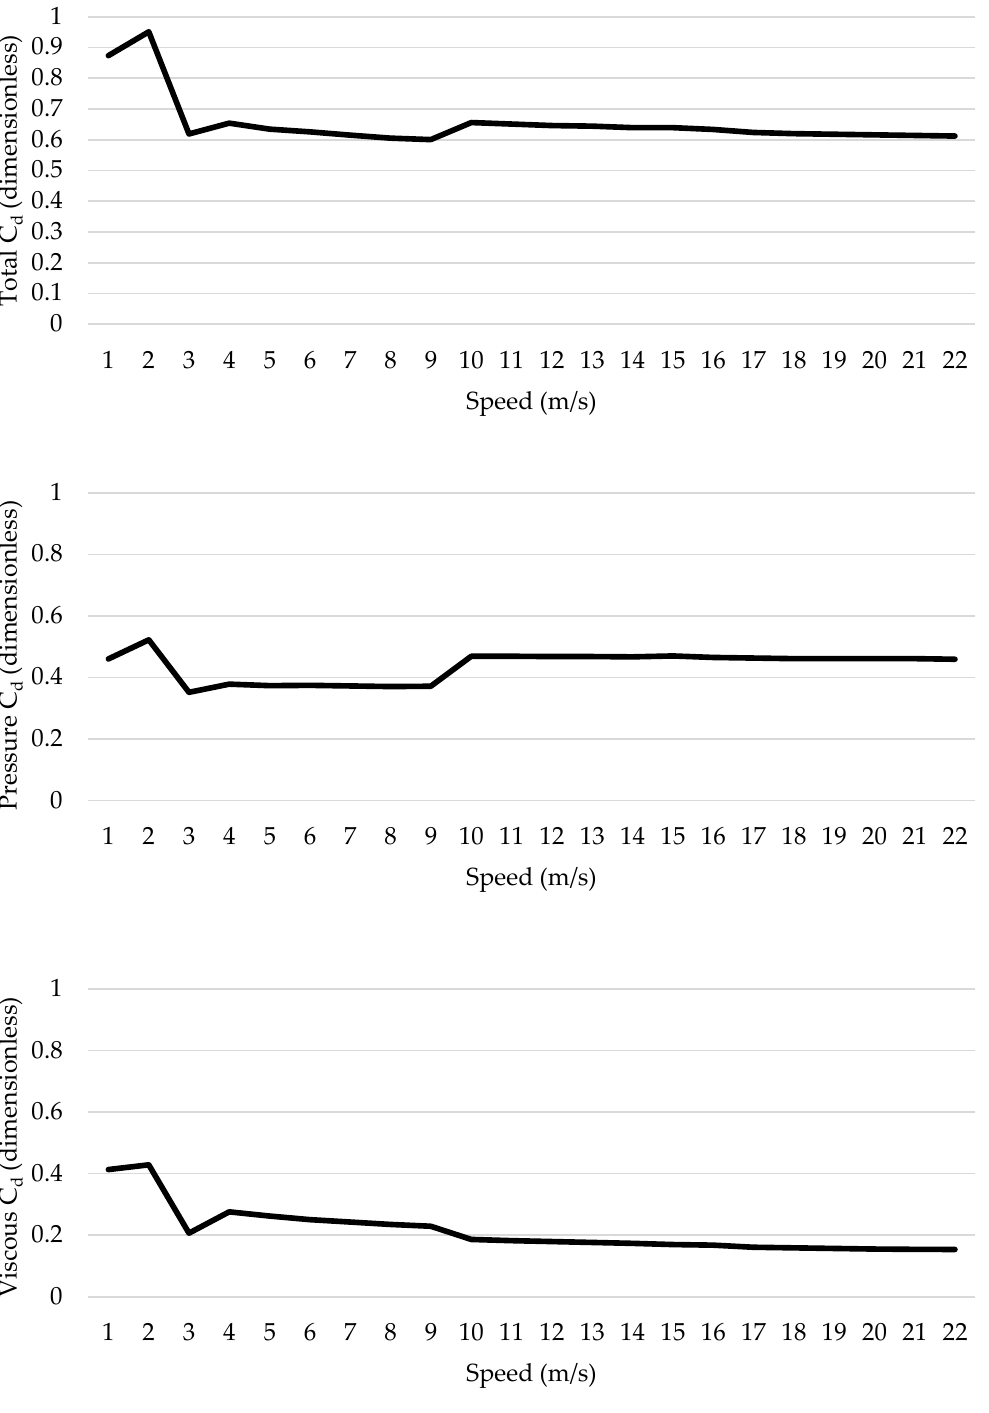
Figure 2. Drag coe ffi cient ( C d ) variations across di ff erent speeds ( top panel ), pressure drag coe ffi cient ( middle panel ) and viscous drag coe ffi cient ( bottom panel ) across di ff erent Figure 2. Drag coefficient (C d ) variations across different speeds (top panel), pressure drag coefficient (middle panel) and viscous drag coefficient (bottom panel) across different speeds.